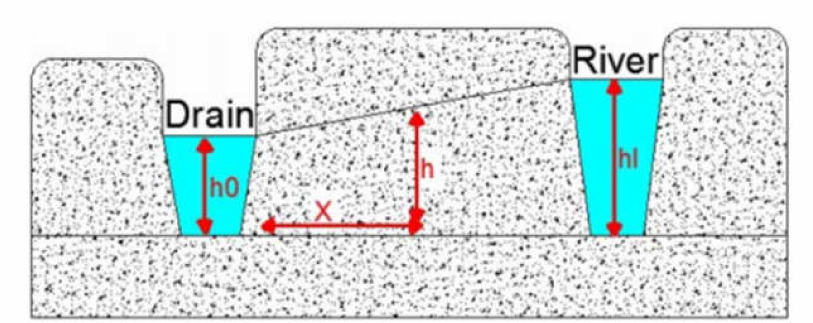
Figure 2. Parameters of numerical